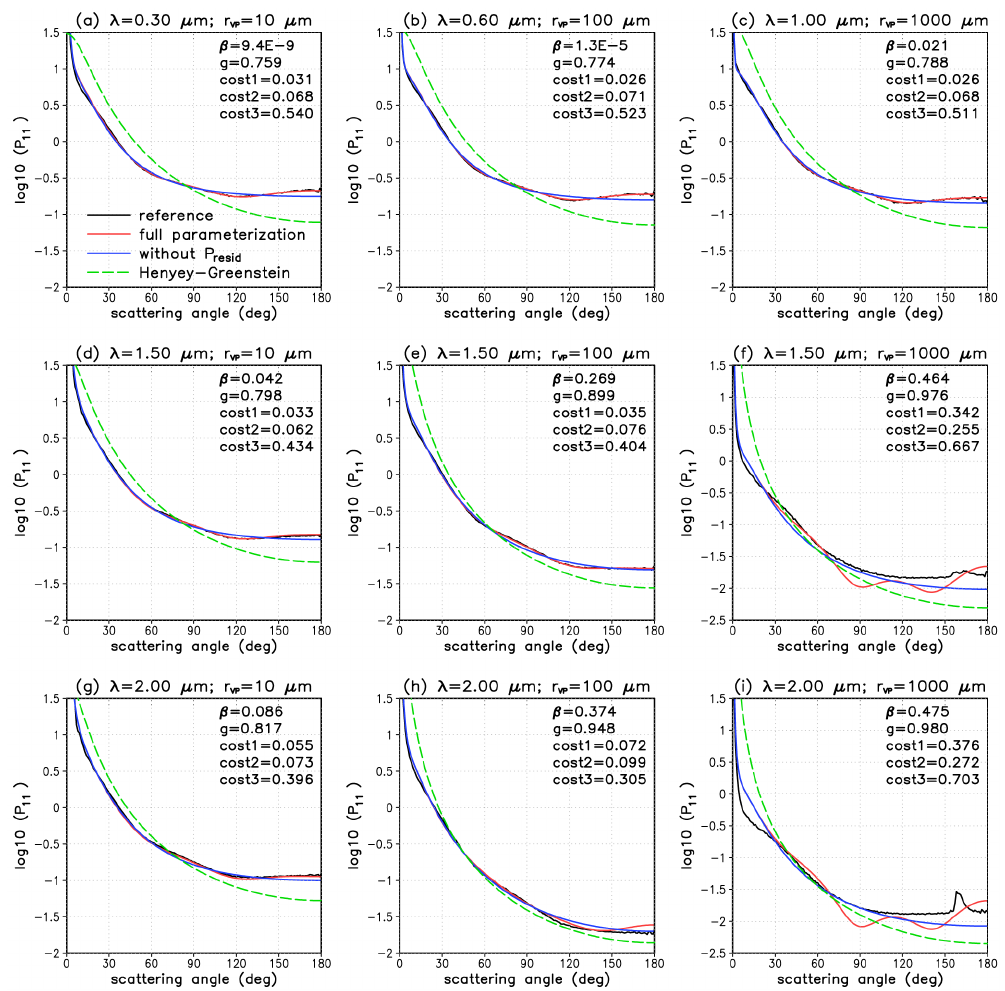
Figure 10. Examples of the reference phase function computed for the OHC (black lines) and of the parameterized phase function for the full parameterization (red lines), the simplified parameterization without the term P resid in Eq. (14) (blue lines) and the Henyey–Greenstein phase function with asymmetry parameter defined by Eq. (13) (dashed green lines) for nine combinations of wavelength λ and volume-to-projected area equivalent radius r vp . For reference, the values of single-scattering co-albedo β , asymmetry parameter g and cost functions for the full parameterization (cost1), for the simplified parameterization (cost2) and for the Henyey–Greenstein phase function (cost3) are listed in each